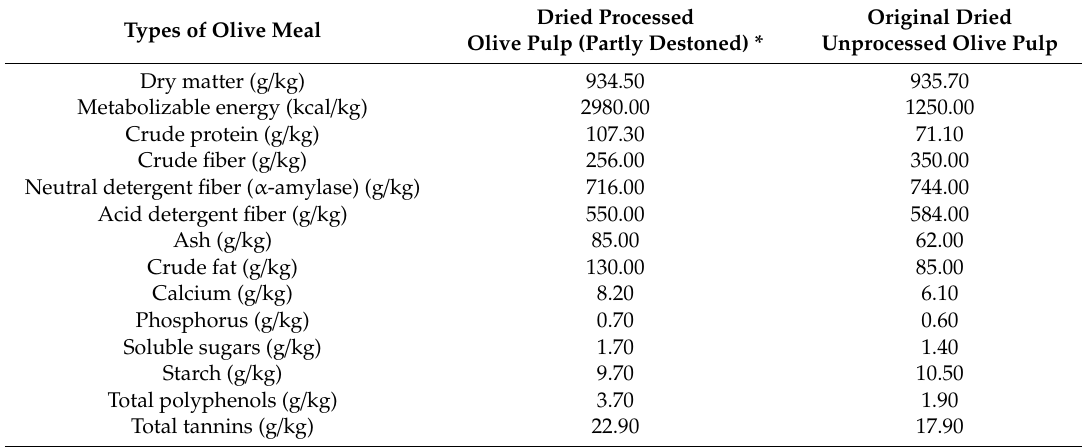
Table 3. Chemical composition of two types of olive meal used in the experiment (as-fed